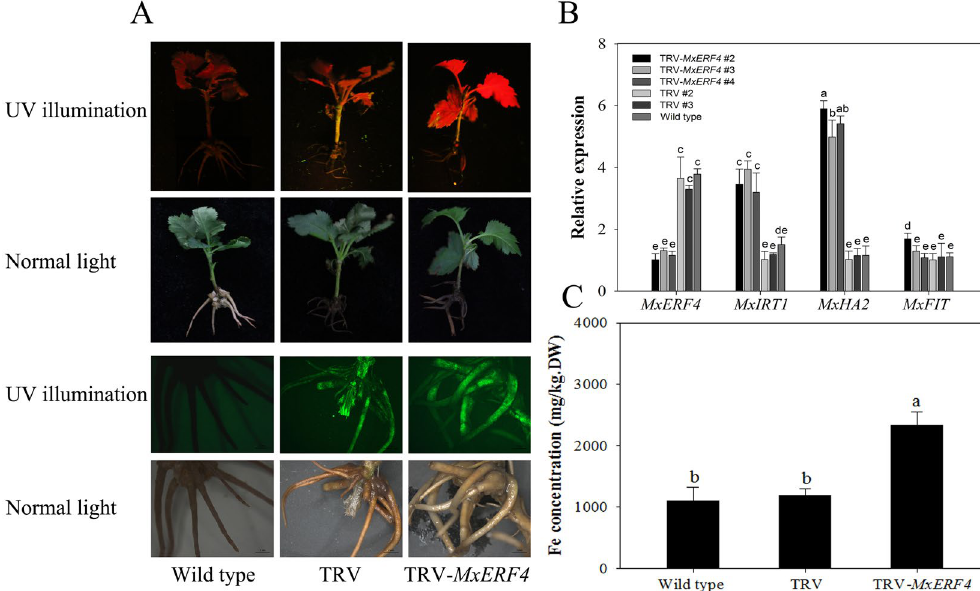
Figure 7. Transient expression of MxERF4 in Malus xiaojinensis . The M. xiaojinensis seedlings were infiltrated with agrobacterium containing a TRV control (pTRV1 + pTRV2-GFP), or TRV carrying a MxERF4 fragment (pTRV1 + pTRV2-GFP- MxERF4 ). ( A ) Green fluorescent protein (GFP) imaging of TRV-GFP- MxERF4 infiltrated M. xiaojinensis seedlings by UV and fluorescence microscopy. ( B ) Quantitative real-time reverse transcription-PCR (qRT-PCR) analysis of MxIRT1, MxHA2 and MxFIT expression in silenced roots. Values are means ± SE of three replicates. Different letters represent statistically different means at P < 0.05 (one-way ANOVA analysis with Duncan post-hoc test). ( C ) Analysis of Fe concentration in silenced roots. Bars represent means ± SE of three replicates. Different letters represent statistically different means at P < 0.05 (one-way ANOVA analysis with Duncan post-hoc